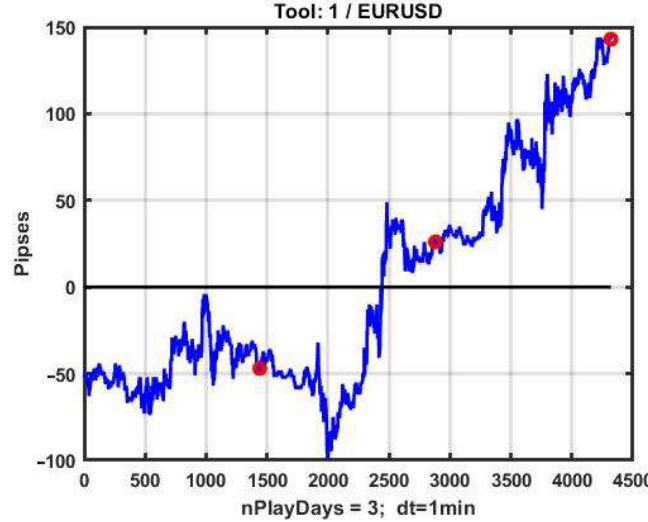
Figure 19. EURUSD quotation chart during three observation days.